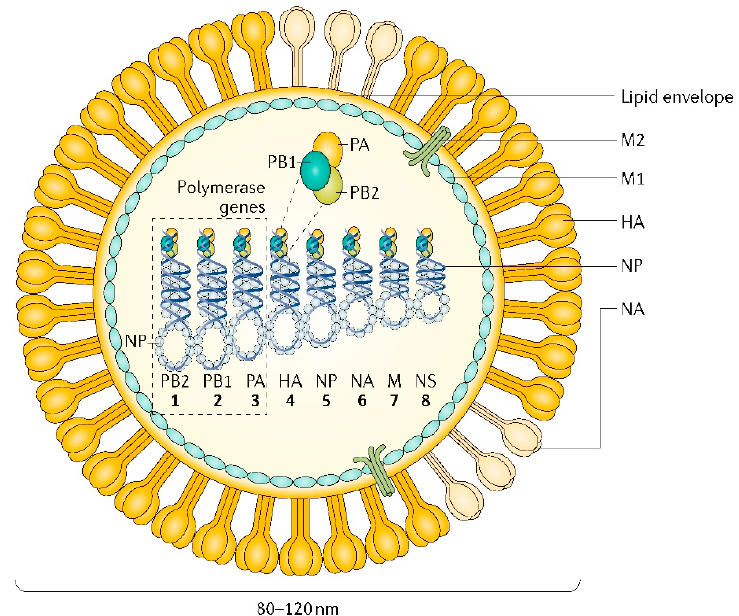
Figure 1. Diagrammatic representation of the influenza A virus (IAV) and its viral genome. Eight internal ssRNA segments encode the major viral proteins of: the RNA-dependent RNA polymerase (PB2, PB1 and PA); HA providing the structural basis for host binding and viral entry; NA facilitating viral release, the binding viral NP; RNA Segment 7 (M) encoding the matrix scaffolding protein (M1) and membrane protein (M2); RNA Segment 8 (NS) encoding a non-structural protein and NEP. Reprinted by permission from Springer Nature: Springer, Nature Reviews Disease Primers [6] , Copyright (2018).